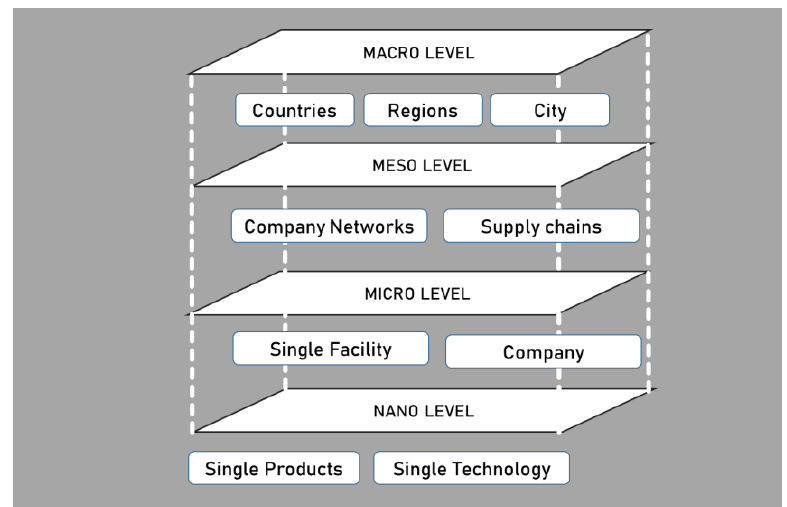
Figure 8: Scale for Application of Circular Economy (Ce) Indicators